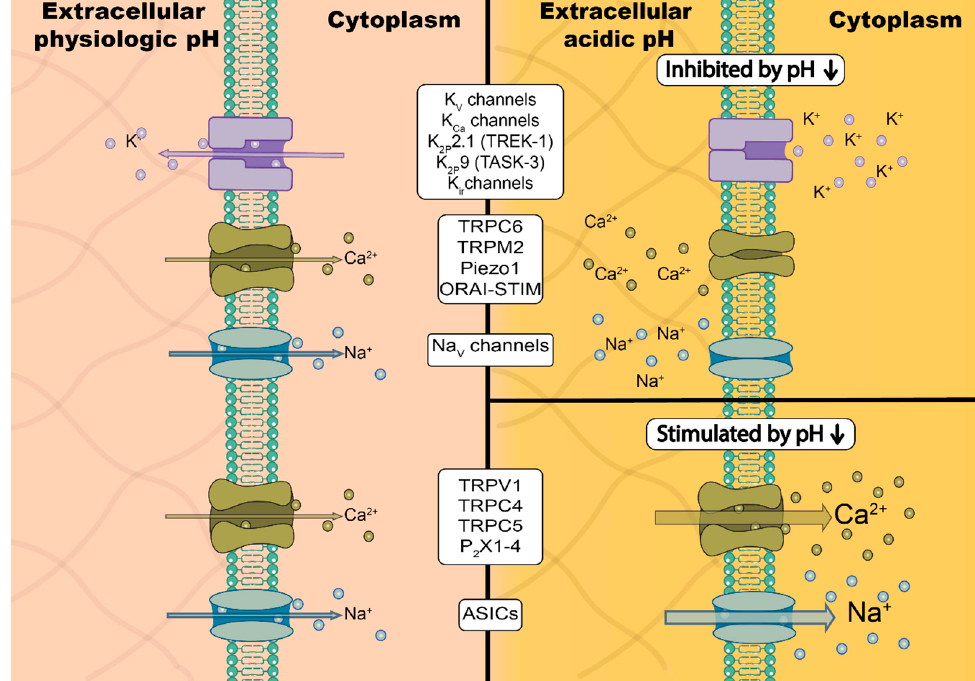
Figure 1. Response of ion channels to an acidic environment. The left side indicates physiological interstitial pH condition (pH o = 7.4), whereas the right side depicts an acidic environment prevalent in tumors (pH o = 6.5). The size of the arrows represents ion flux rate. Table 1. pH-dependence of ion channels involved in cancer.